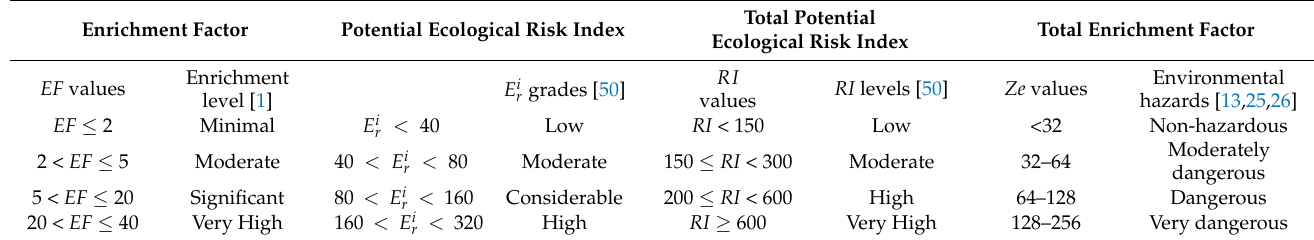
Table 1. Grades of enrichment factor ( EF ), potential ecological risk index ( E i r ), total potential ecological risk index ( RI ) and total enrichment factor ( Ze